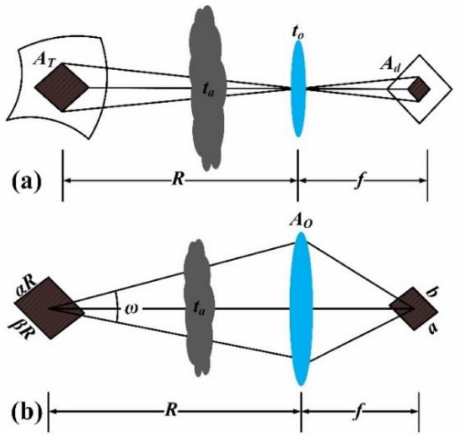
Figure 5. ( a ) Imaging process and ( b ) radiative transfer process between certain ground object and single pixel of image